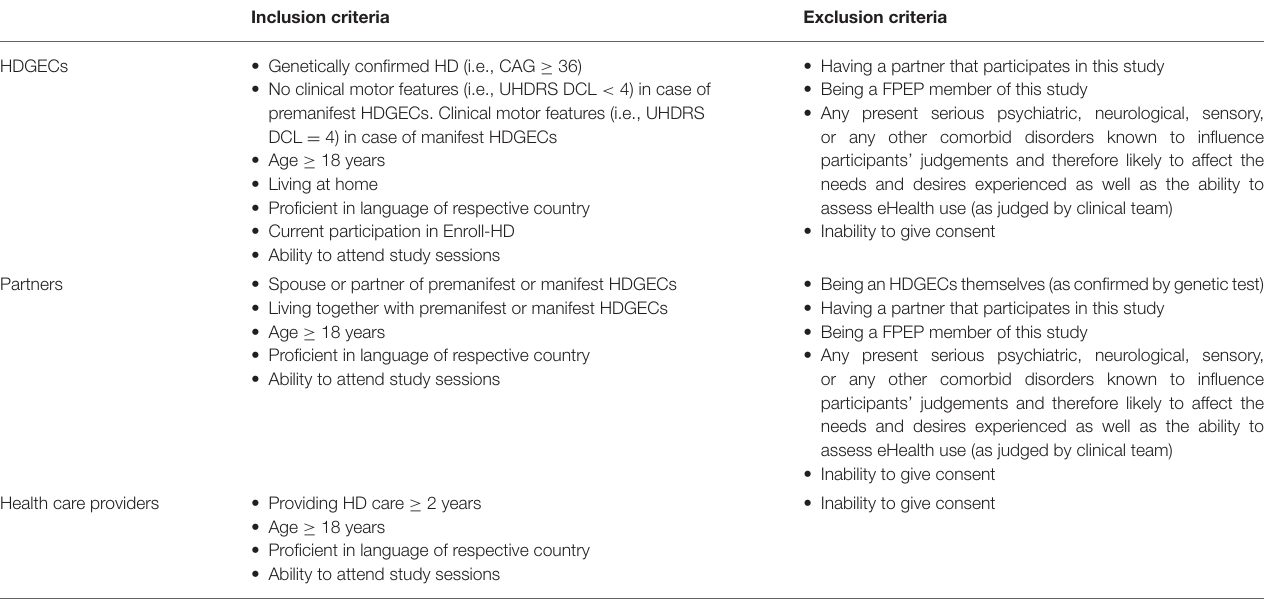
TABLE 2 | Eligibility criteria for study